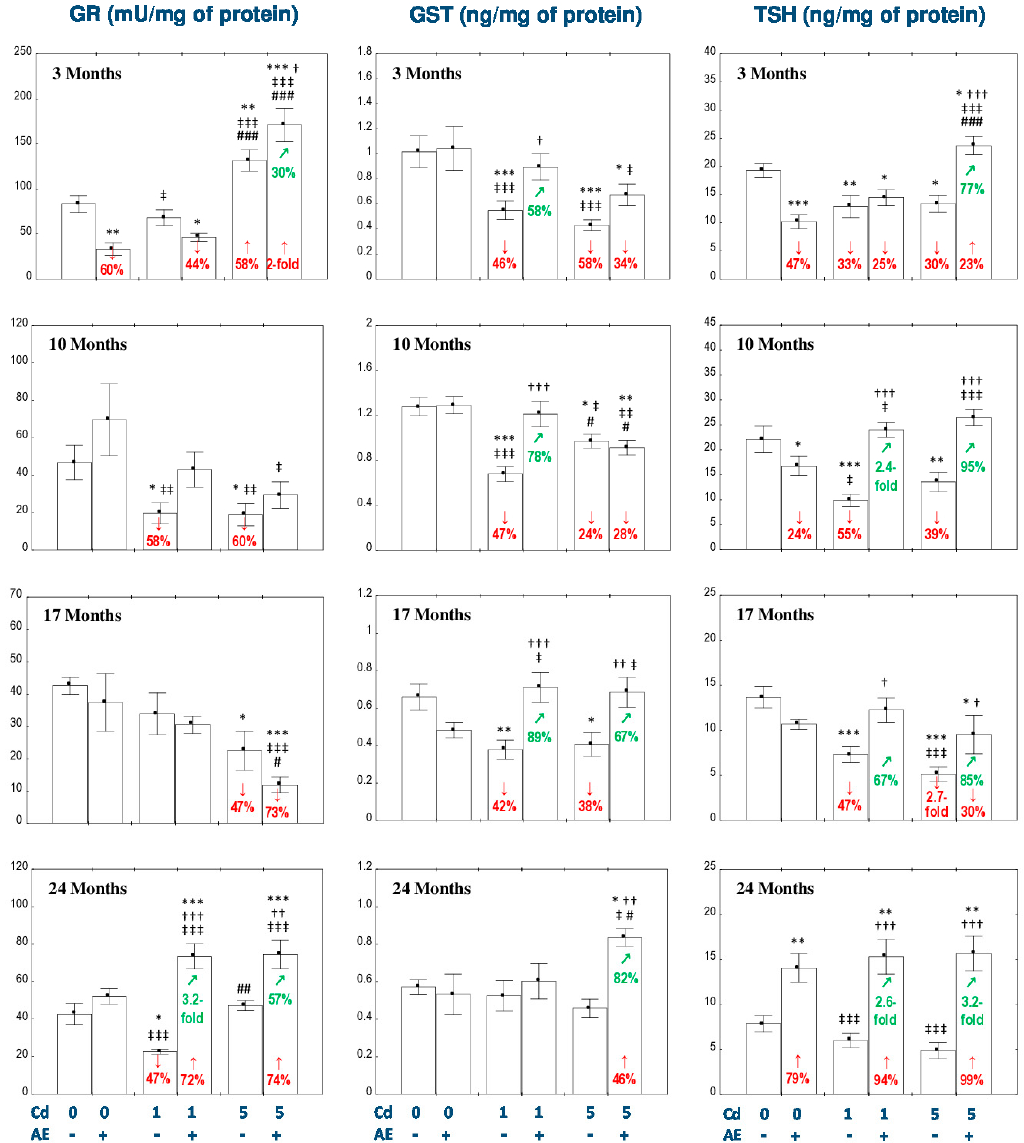
Figure 2. The effect of the extract from the berries of Aronia melanocarpa L. (AE) on the activity of glutathione reductase (GR) and the concentrations of glutathione S-transferase (GST) and total thiol groups (TSH) in the liver of rats exposed to cadmium (Cd). The rats received Cd in the diet at the concentration of 0, 1, and 5 mg Cd/kg and/or 0.1% aqueous AE (+) or not (-). Data are presented as mean ± SE for eight rats, except for seven animals in the AE, Cd 1 , and Cd 5 group after 24 months. Statistically significant differences (ANOVA, Duncan’s multiple range test): * p < 0.05, ** p < 0.01, *** p < 0.001 vs. control group; † p < 0.05, †† p < 0.01, ††† p < 0.001 vs. respective group intoxicated with Cd alone; ‡ p < 0.05, ‡‡ p < 0.01, ‡‡‡ p < 0.001 vs. group receiving AE alone; # p < 0.05, ## p < 0.01, ### p < 0.001 vs. respective group receiving the 1 mg Cd/kg diet (alone or with AE). Numerical values in bars disclose the percentage changes or factors of changes in comparison to the control group ( ↓ , decrease; ↑ , increase) or the respective group receiving Cd alone ( ↗ , increase). In the rats receiving the diet containing 1 mg Cd/kg, the activity of SOD in the liver decreased (by 28–100%) after 3–17 months, while the activity of CAT was declined (by 50%) only after 24 months